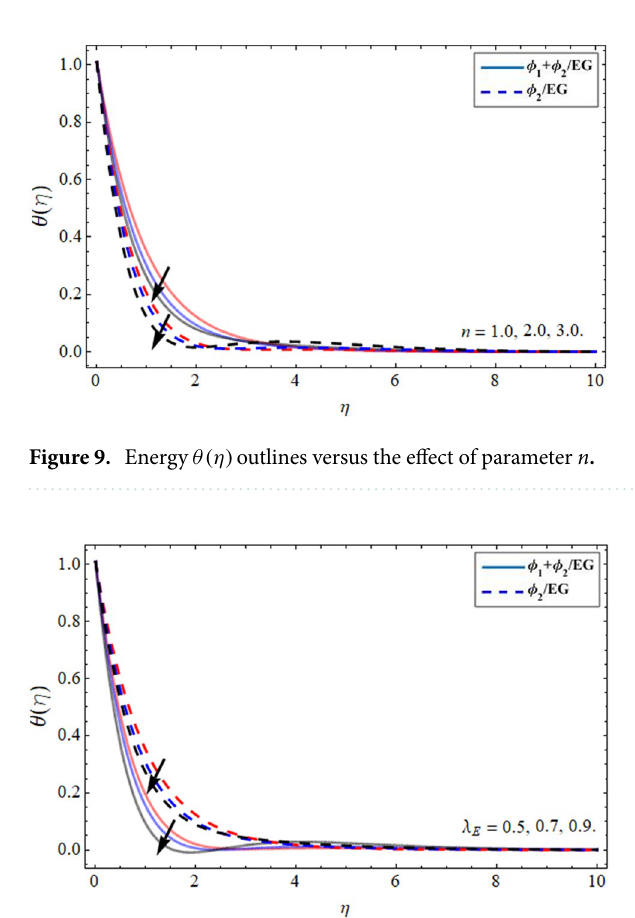
Figure 8. Energy θ(η) outlines versus the effect of nanoparticle volume friction φ .